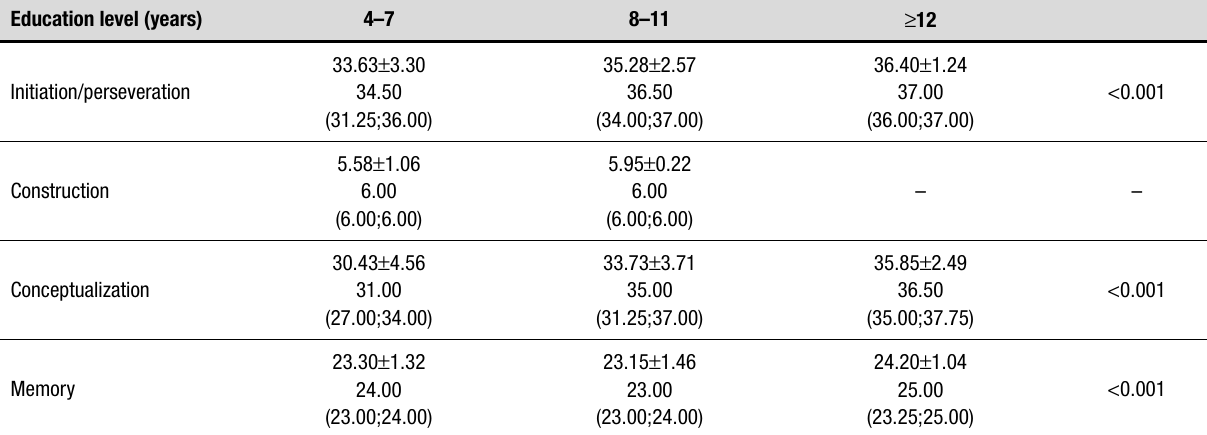
Table 4. Continuation.